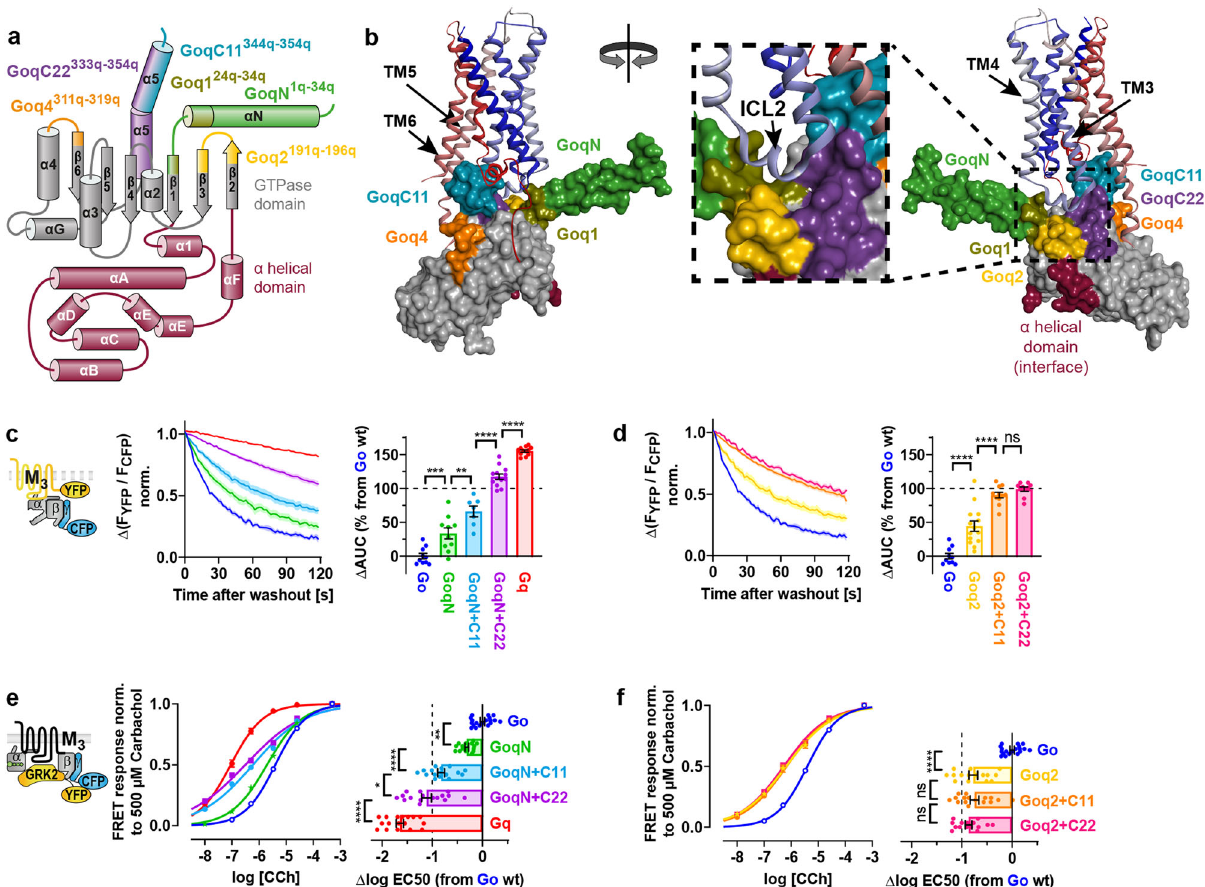
Fig. 3 Examination of chimeric Go subunits achieving Gq-like binding and activation properties with M3R. a Colored segments in the schematic G protein structure illustrate amino acids in Go replaced by the corresponding ones from Gq in various chimeric Goq subunits (details in Supplementary Fig. 5a, b). b Utilizing the M 1 R-G 11 complex structure (pdb: 6oij) 19 , chimeric structures are depicted by different views of the G 11 surface in relation to the M 1 R (N-terminus: dark-blue to C-terminus: red). The C-terminal end of the α N helix (aa 30 – 35), being part of Goq1 and GoqN is not resolved in the structure. c – d G protein binding experiments were performed in analogy to Fig. 1b. Dissociation kinetics of M 3 R-G protein complexes were quanti fi ed by determining the AUC as described in Fig. 1b and plotted in the bar graphs as relative changes of the AUC from Go. ( c Go; n = 10, GoqN; n = 10, GoqN + C11; n = 7, GoqN + C22; n = 13, and Gq; n = 12. d Goq2; n = 14, Goq2 + C11; n = 11, Goq2 + C22; n = 10, and Go; n = 10 duplicated from c ). e – f Indirect G protein activation measurements were performed in analogy to Fig. 2a, b. Individually calculated EC50 values were plotted in horizontal bars as relative changes from the averaged EC50 of Go. ( e Go; n = 19, GoqN; n = 16, GoqN + C11; n = 16, GoqN + C22; n = 16 and Gq; n = 17 duplicated from Fig. 2b. f Goq2; n = 15, Goq2 + C11; n = 16, Goq2 + C22; n = 15 and Go; n = 19 duplicated from e ). All data points are represented as means ± SEM (error bars in the concentration-response curves are not visible if they were smaller than the size of the symbol) and colored as indicated in the corresponding bar graphs (Go = blue, GoqN = green, GoqN + C11 = light blue, GoqN + C22 = purple, Gq = red, Goq2 = yellow, Goq2 + C11 = orange, Goq2 + C22 = pink). Statistical analyses were performed using one-way ANOVAs followed by Tukey ’ s posttests ( c – f , * P < 0.05, ** P < 0.01, *** P < 0.001, **** P < 0.0001, ns if P ≥ Goq1 + C22) carrying only 11 amino acids of the α N/ β 1 hinge of G α q instead of the whole N-terminus (Fig. 3a, b). Even though